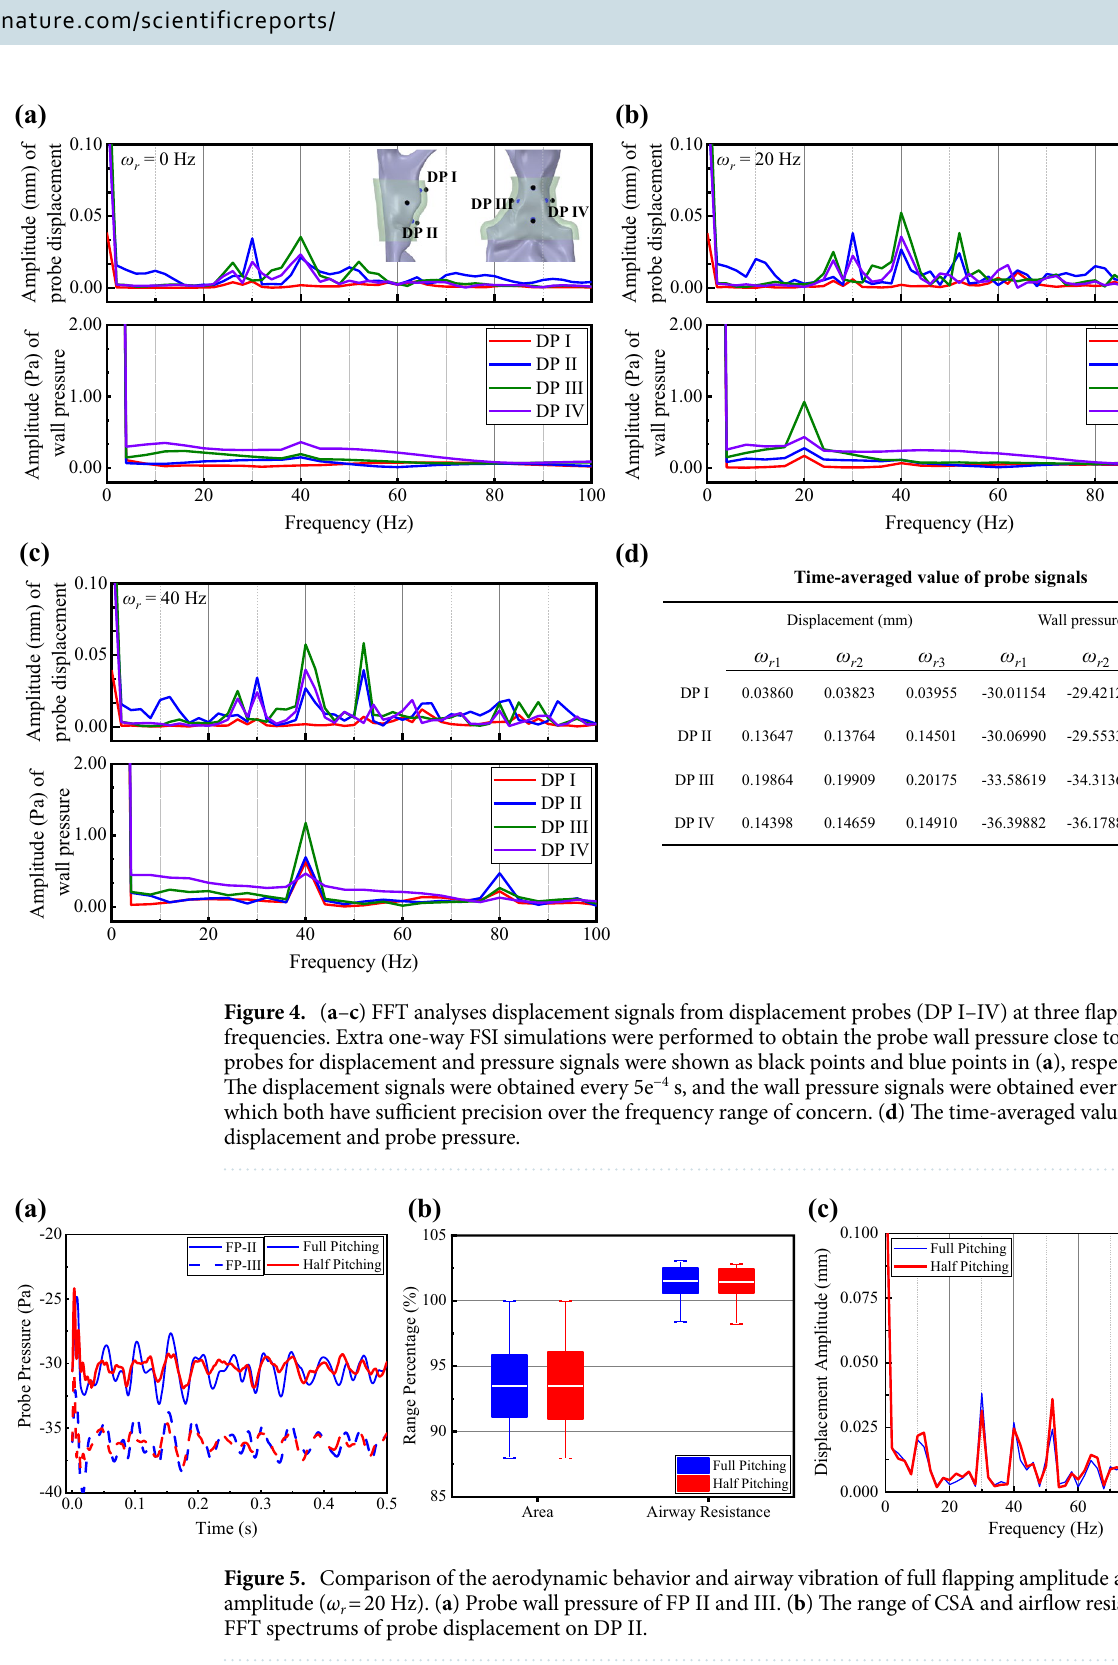
Figure 5. Comparison of the aerodynamic behavior and airway vibration of full flapping amplitude and half amplitude ( ω r = 20 Hz). ( a ) Probe wall pressure of FP II and III. ( b ) The range of CSA and airflow resistance. ( c ) FFT spectrums of probe displacement on DP